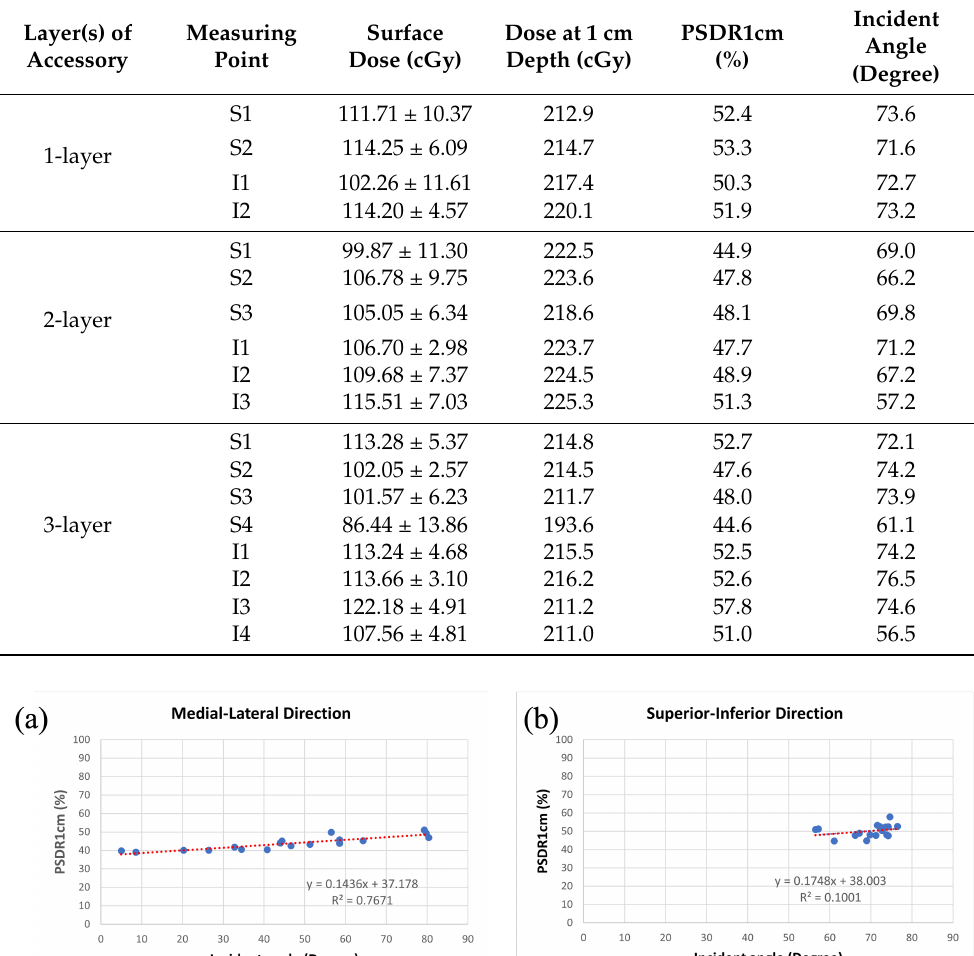
Figure 7. The relationship between PSDR1cm and incident angle. Both the trendlines (red dashed lines) are under linear regression. ( a ) The medial-lateral direction and ( b ) the superior-inferior